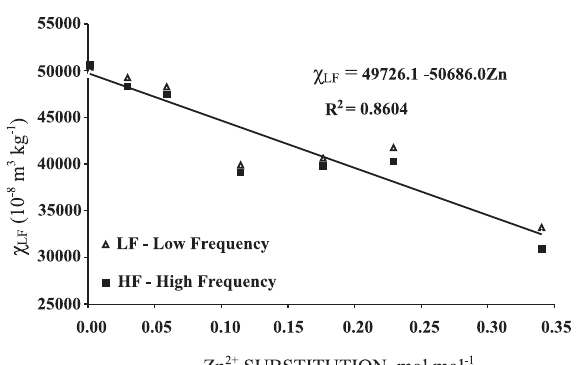
degrees.Figure 5. Mass-specific magnetic susceptibility ( XXXXX